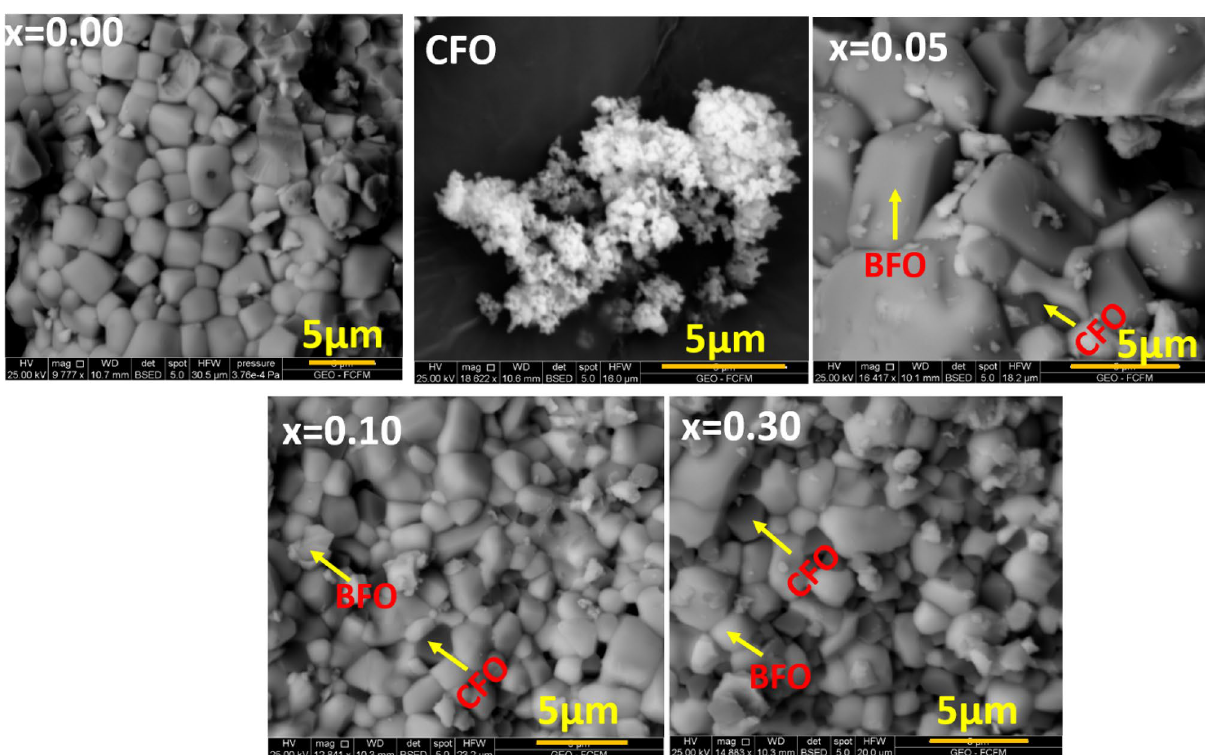
Figure 4. SEM images of (1 − x) BFO–xCFO (CFO, x = 0.00, 0.05, 0.10 and 0.30) ceramic pellets sintered at 980 °C for 5